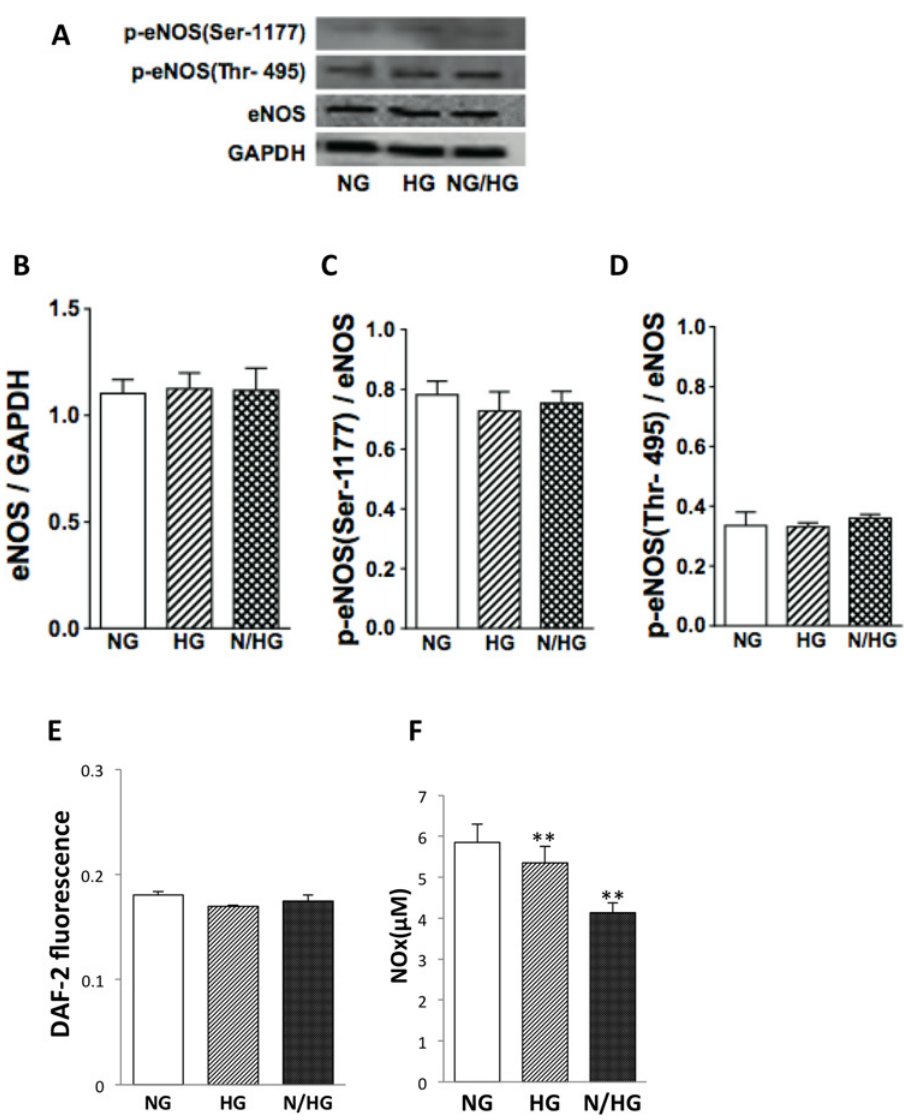
Fig 5. eNOS activity in HUVECs exposed to high glucose. NG, constant normal glucose (5 mM); HG, constant high glucose (22 mM); and N/HG, 5 mM alternating with 22 mM glucose. (A) Typical Western blots for total eNOS, Ser-1177 phosphorylated eNOS, and Thr-495 phosphorylated eNOS are shown. GAPDH served as the loading control. (B-D) Summary of quantification of densitometric measurement of the immunoblot data. Total eNOS expression and eNOS phosphorylation levels were normalized to GAPDH and total eNOS, respectively. (E) NO production by HUVECs, using the fluorescent dye DAF-2-DA. (F) The data of NOx (NO2 - and NO3 - ), NO metabolites measured by